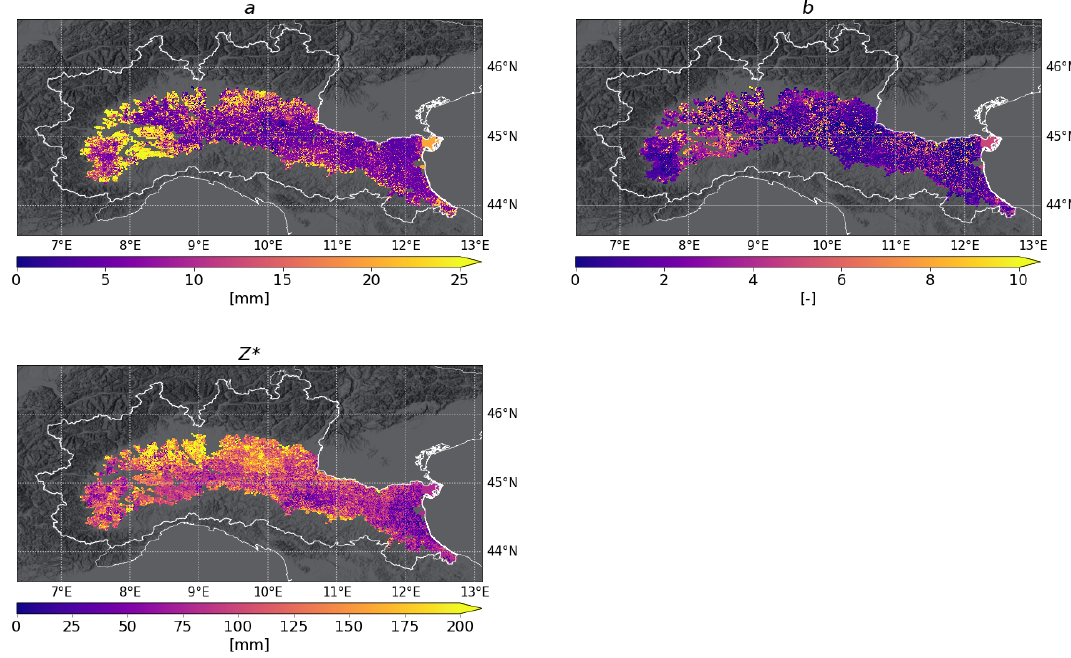
Figure A3. Spatial distribution of the calibrated values of the parameters a , b , and Z ∗ over the Po valley.